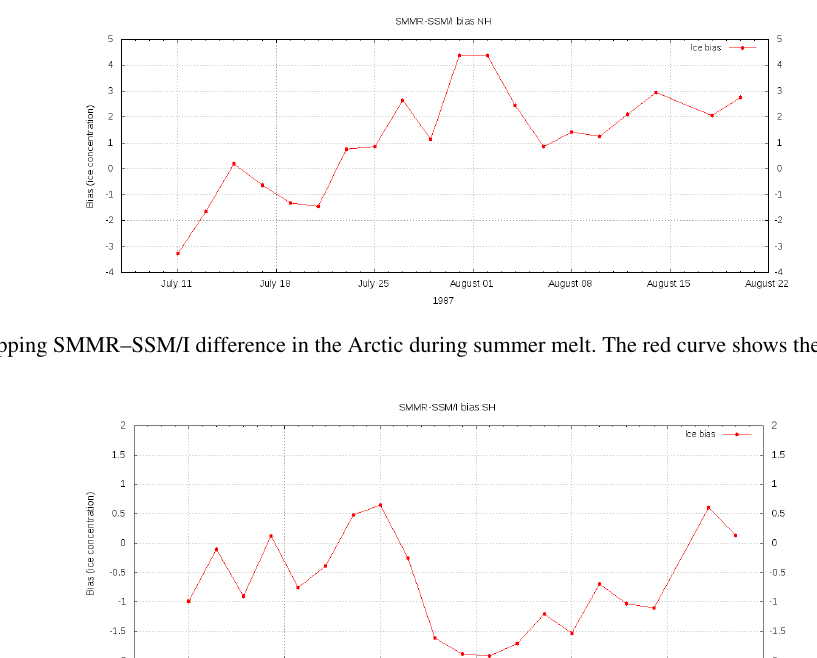
Figure 7. The ESICR and NIC ice chart standard deviation of the difference around Antarctica. The red curve is for ice and the black curve is for water. No ice charts were available to us from 1994 to 2006.